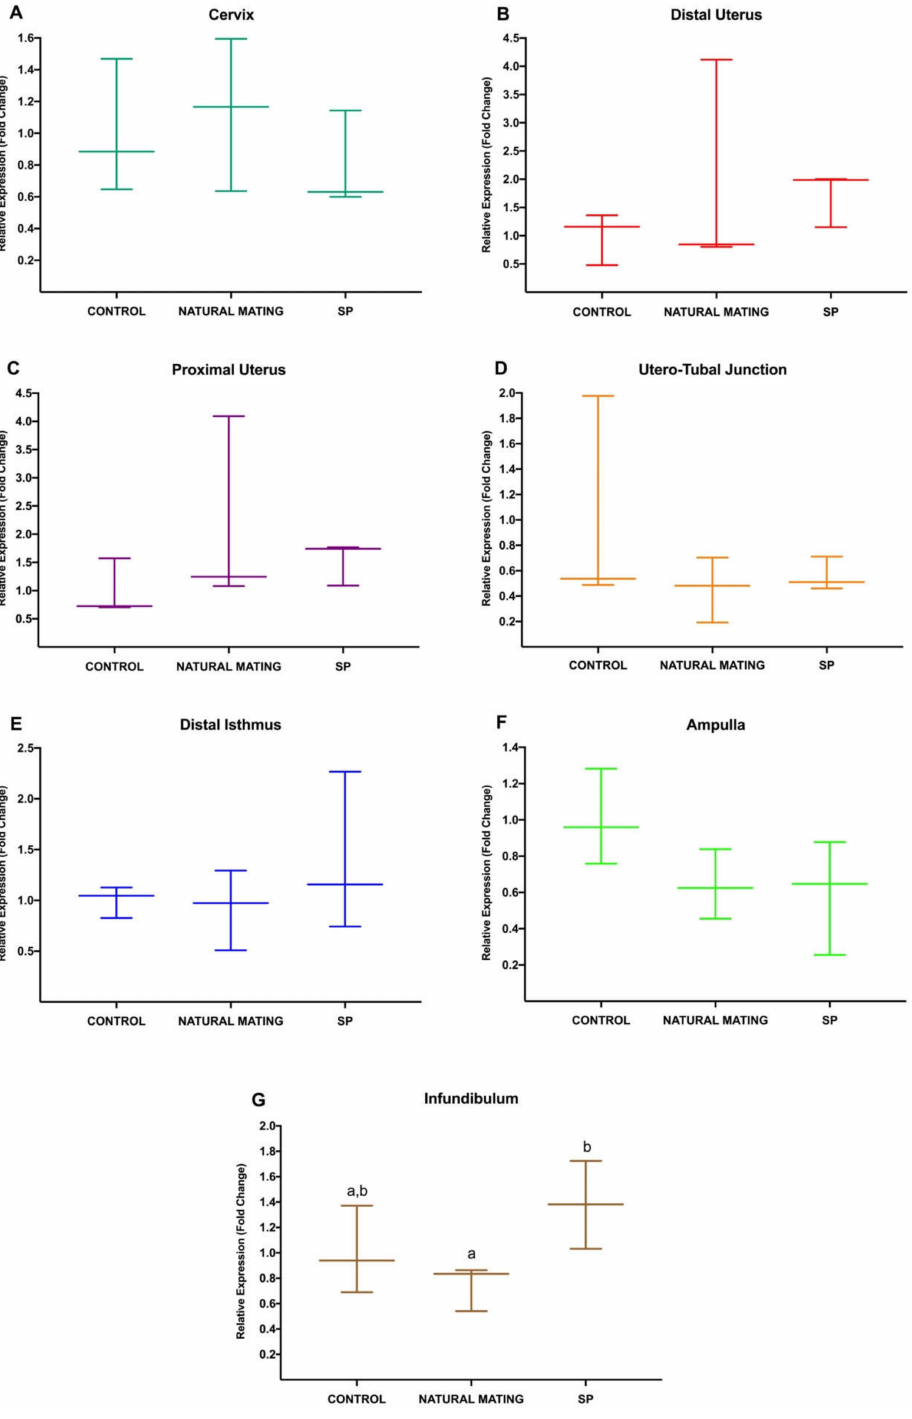
Figure 1. ( A – G ). Gene expression di ff erences in NR3C1 in the di ff erent anatomical segments (cervix to infundibulum; Experiment 1) ( A – G ), between negative control, natural mating, and seminal plasma (SP) treatments. Di ff erent letters indicate values that di ff ered significantly between treatments in the same anatomical region ( p < 0.05). The expression was relativized using the negative control as a reference. Median (minimum,